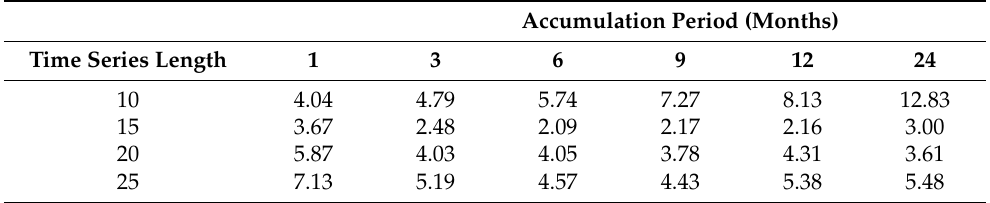
Table 1. The AD test rejection frequency (%) for the Genlog distribution for water balance (P-PET) time series data with lengths of 10, 15, 20, and 25 years for all accumulation